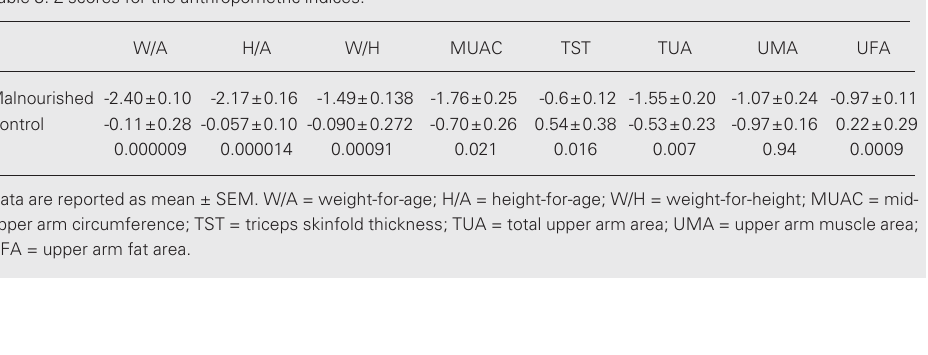
Table 3. Z scores for the anthropometric indices. W/A